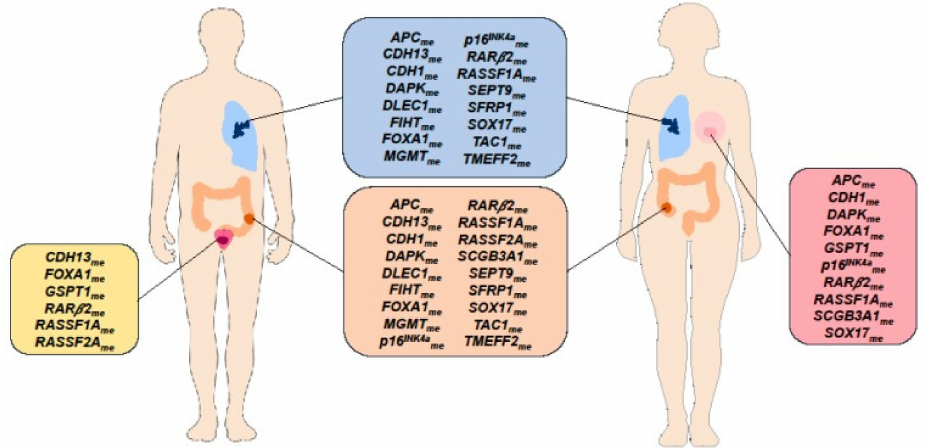
Figure 10. Circulating cell-free DNA methylation-based biomarkers described in literature for cancer detection which are common to at least two cancer types [Breast Cancer (pink box), Lung Cancer (blue box), Prostate Cancer (yellow box), Colorectal Cancer (orange box)]. Reprinted with permission from [189]. 2020, Cells,